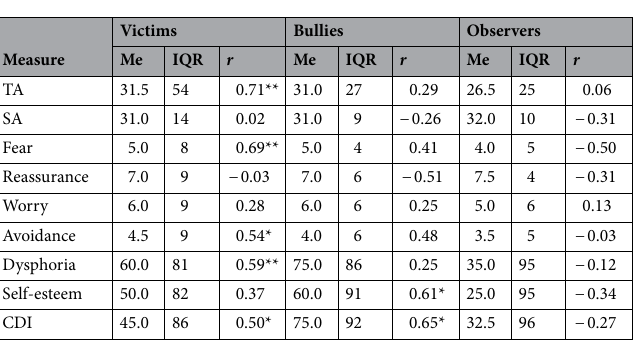
Table 3. Correlation between school bullying questionnaire scores and clinical scales. TA trait anxiety, SA state anxiety, CDI children’s depression inventory. * p < .05; ** p < .001.